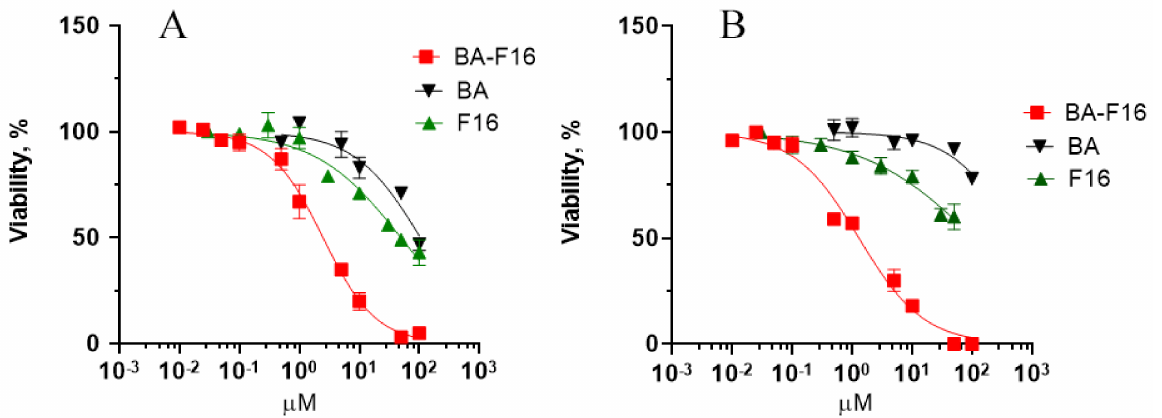
Figure 2. Dose dependence of the effect of compounds BA, F16, and BA–F16 on the survival of MCF-7 ( A ) and HF ( B ) cells. Cytotoxicity was assessed 48 h after the addition of substances by crystal violet indicator. Data (mean ± SEM) of 4 independent experiments are